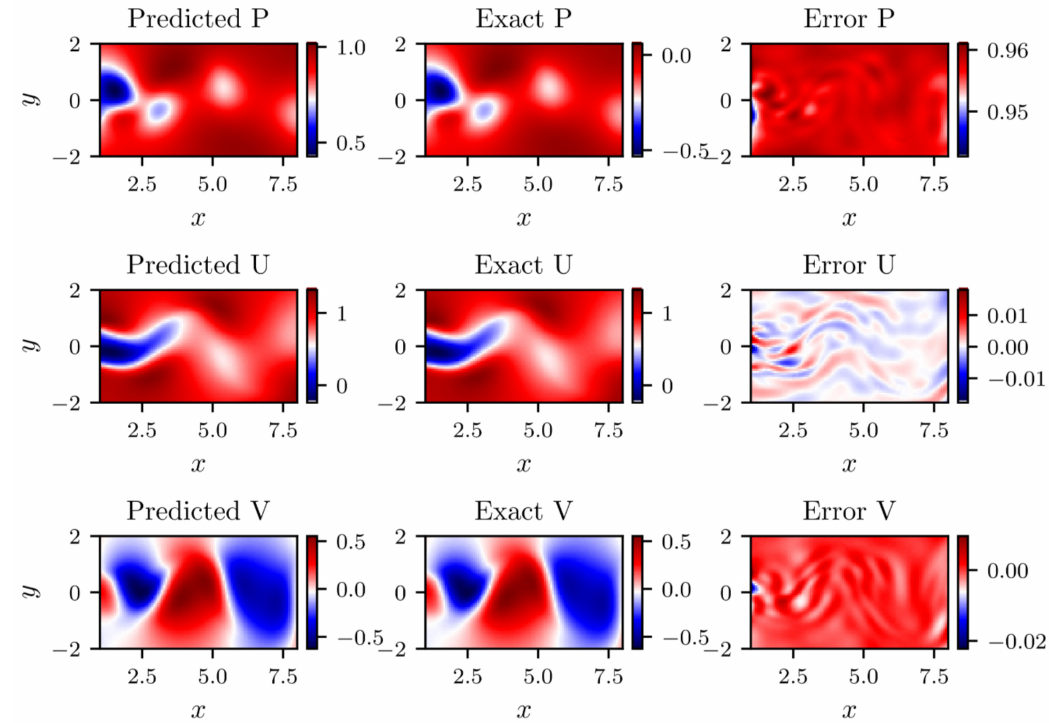
Figure 13. 2D predicted versus exact flow information at test time (with clean data).